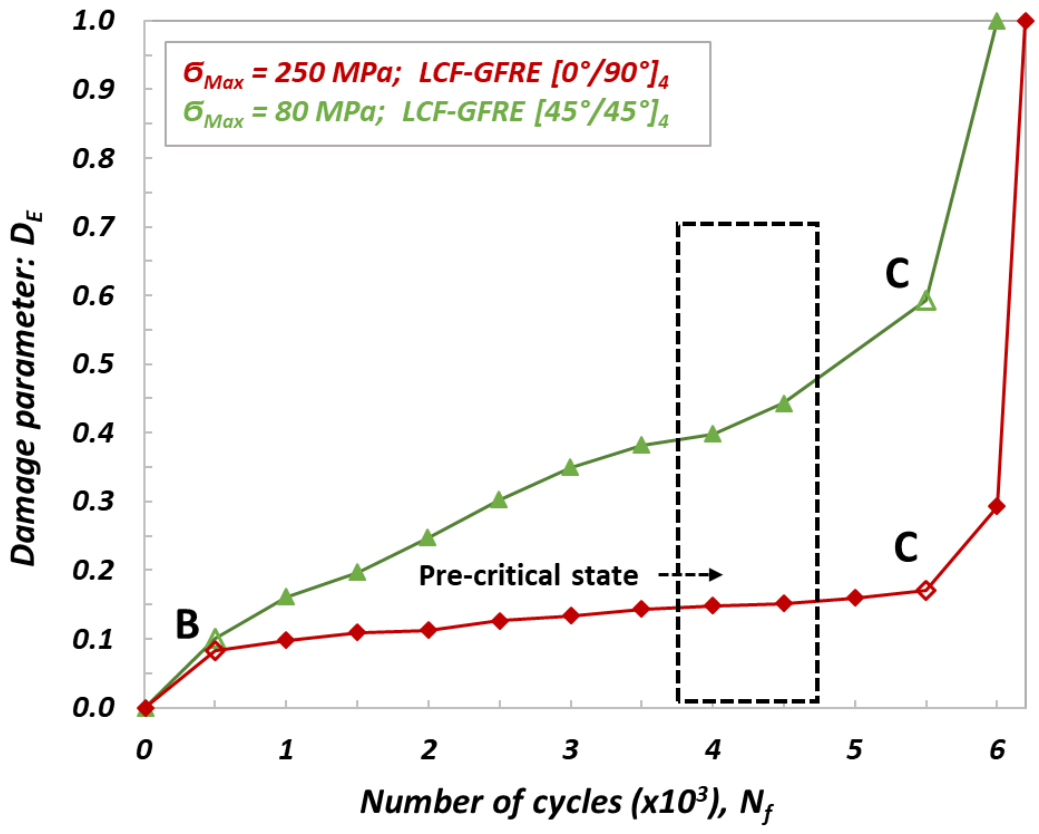
◦ /90 ◦ ] ◦ /45 ◦ ] 4 and GFRE [45 4